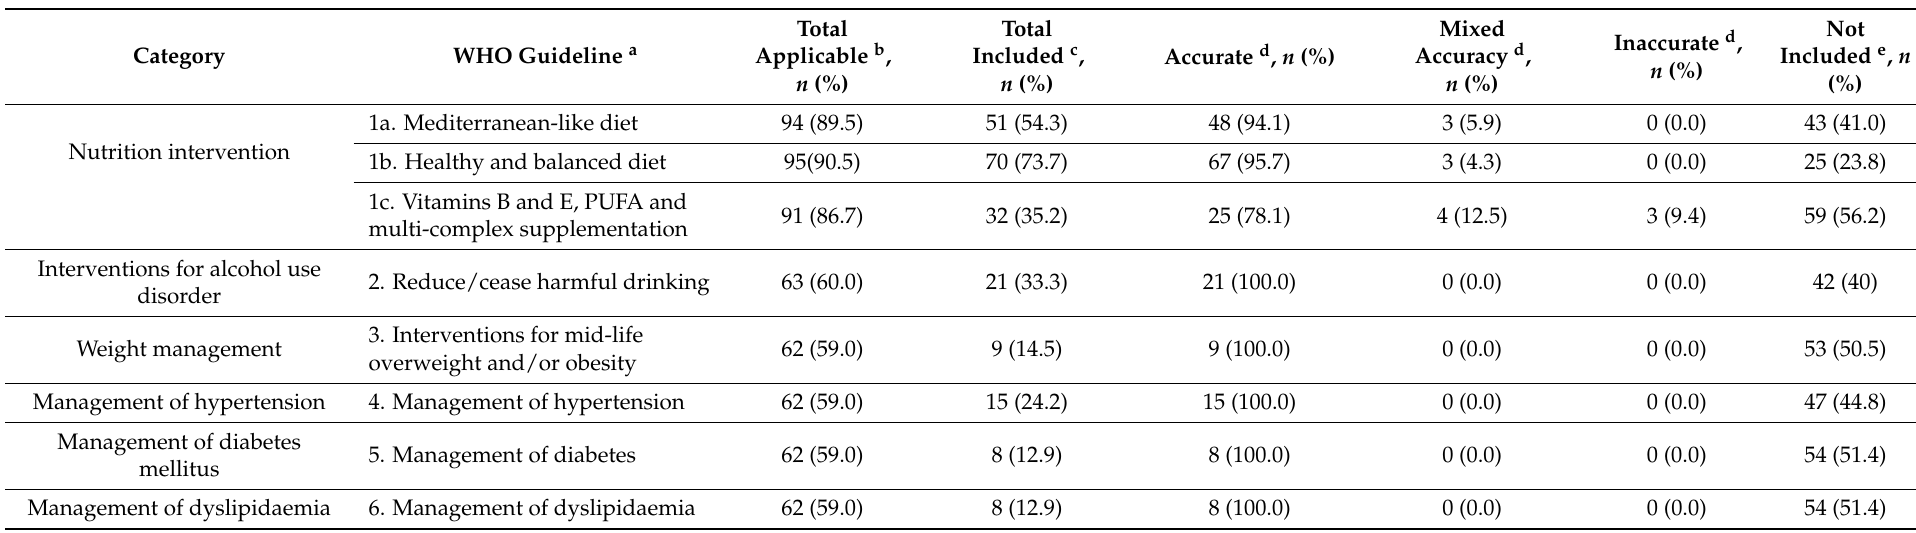
Table 4. Webpages n (%) and accuracy of included information related to the World Health Organisation (WHO) guidelines for risk reduction of cognitive decline and